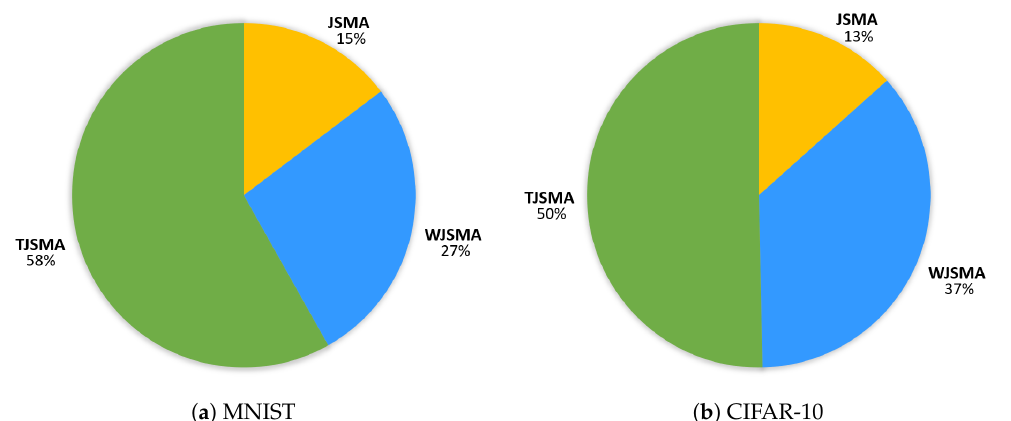
Figure 4. Distribution of the (strict) dominance of JSMA, WJSMA and TJSMA over the MNIST ( a ) and CIFAR10 ( b ) datasets (training and test sets included).